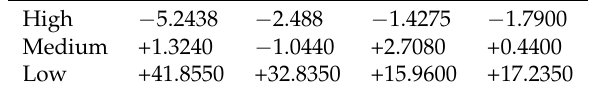
Table 4. Percentage deviation from the quality satisfaction using